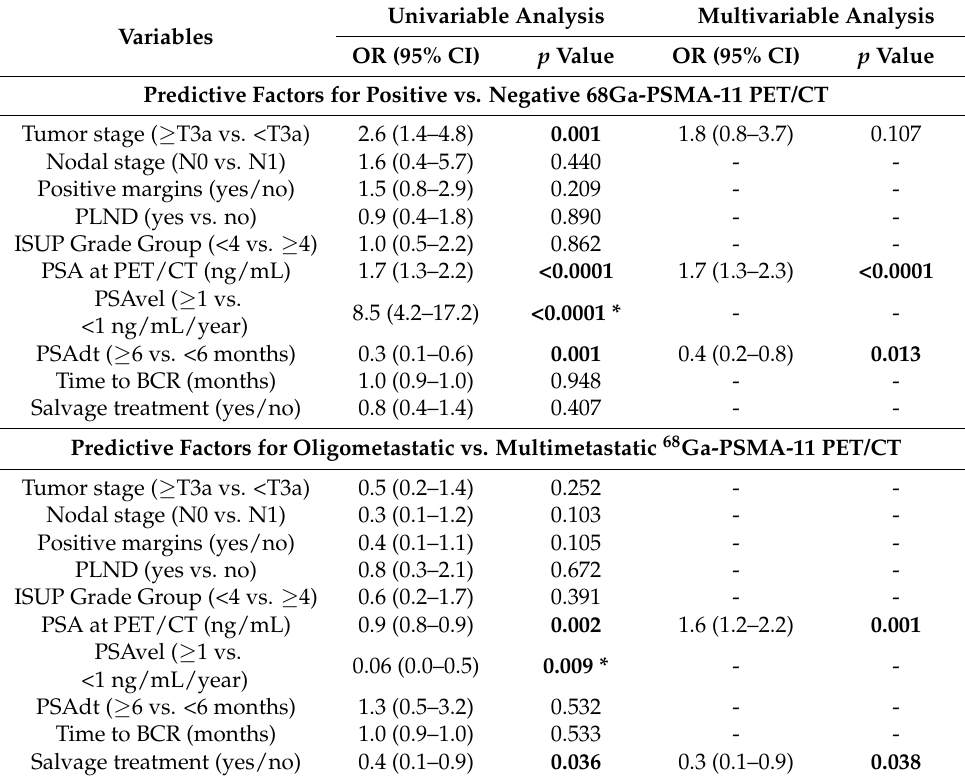
Table 3. Univariable and multivariable logistic regression analysis. Univariable Analysis Multivariable Variables